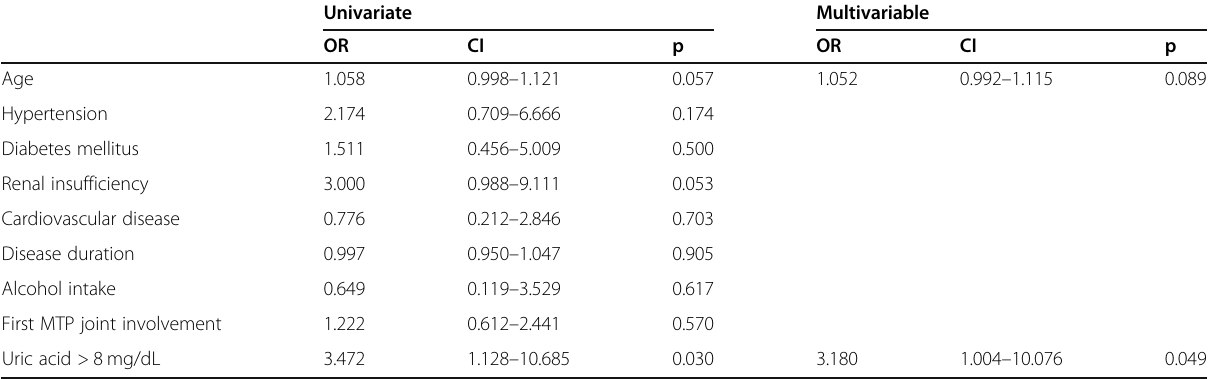
Table 4 Factors associated with dual-energy computed tomography positivity (first attack)